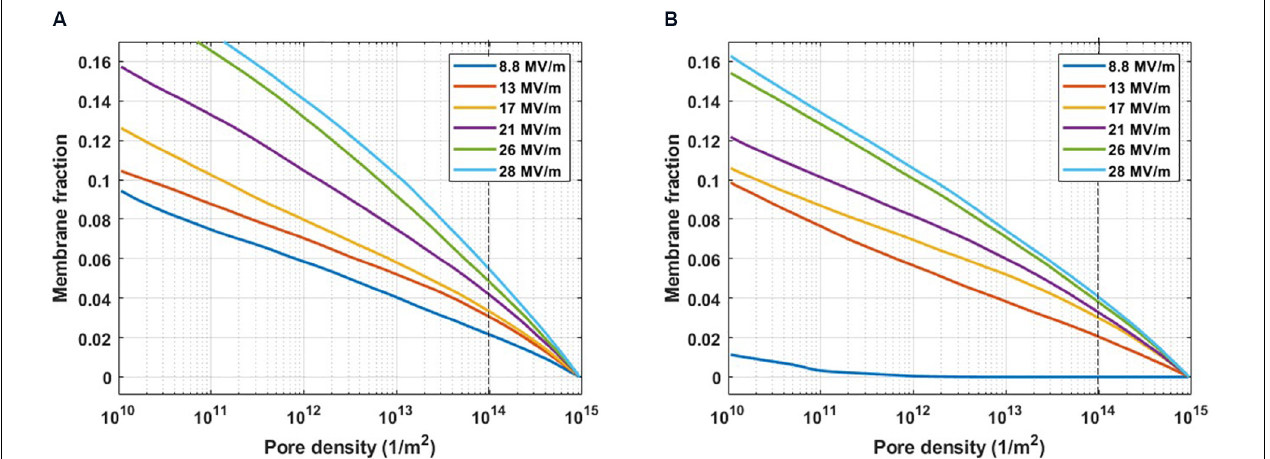
FIGURE 3 | Pore density histogram on a single cell evaluated for the complementary cumulative distribution function. The fraction of the PM (A) and ER (B) membrane where the pore density reached at least the value indicated on the x-axis, at increasing electric field amplitudes from 8.8 to 28 MV/m. The dashed line indicates the threshold value for a significant density of the pore (10 14 m - 2